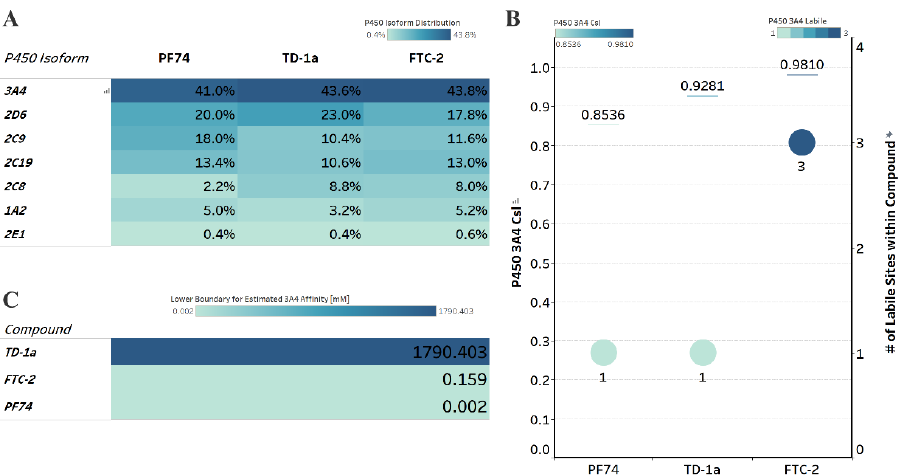
9 of 22 Figure 5. ( A ) Plot showing the StarDrop (Optibrium, Ltd., Cambridge, UK) – derived logS versus a multimetric oral non-CNS profile score. Importance for the score: logS = 0.9, HIA = 0.85, logP = 0.6, logD = 0.6, hERG pIC50 = 0.4, 2D6 affinity category = 0.3, 2C9 pKi = 0.3, P-gp category = 0.3, PPB90 category = 0.2, BBB category = 0.11, BBB log(brain:blood) = 0.11 ( B ) P-gp category, ( C ) PPB90, Plasma protein binding >90%, ( D ) HIA, human intestinal absorption category, and probability of prediction of FTC-2, TD-1a and PF-74 . The size of the circles correlates with the corresponding score or prob- ability. A significant hurdle for PF7 4′ s development is its poor metabolic stability [20]. Orally administered drugs must first pass the intestinal wall, followed by the portal circulation to the liver before reaching the bloodstream. Both sides are locations for first-pass metab- olism and can adversely metabolize drugs before adequate plasma concentrations are reached. Therefore, we next sought to investigate whether or not our compounds had im-